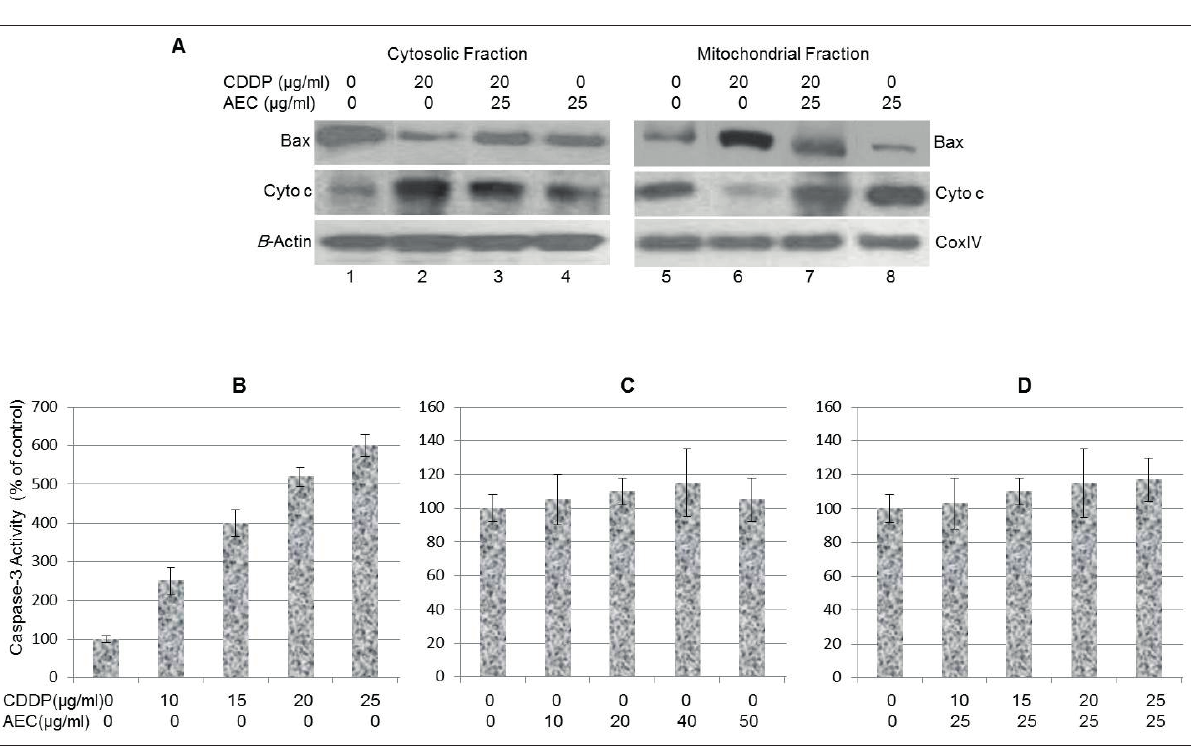
Fig. 3. aec prevented cddp-induced activation of Bax and caspase-3 and release of cytochrome c. (a) left panels: immunob- lot analysis of Bax translocation to mitochondria. right panels: immunoblot analysis of cytochrome c release. The immunoblots show in control cells, the majority of Bax was detected in the cytosolic fraction (lane 1), and, after cddp treatment, a significant amount of Bax moved to the mitochondrial fraction (lane 6). importantly, aec effectively decreased potentiality of cddp- induced Bax accumulation in mitochondria (lane 7). meanwhile, cytochrom c (cyto c) is accumulated in mitochondrial fraction (lane 5) and cddp treatment significantly induced release of mitochondrial cytochrome c into cytosolic compartment (lane 2), which was accompanied by reduction of the cytochrome c in mitochondrial fraction (lane 6). aec alone did not induce Bax ac- cumulation or cytochrome c release (lanes 4 and 8). (B-d) Histograms showing cddp remarkably induced caspase-3 activity, in a dose-dependent manner (B); aec insignificantly affected basal level of caspase-3 activity (c), and aec abrogated potentiality of cddp-induced caspase-3 activation